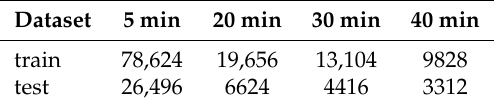
Figure 7. The numbers of training data and test data distribution at different time scales. Table 1. The data size of different time